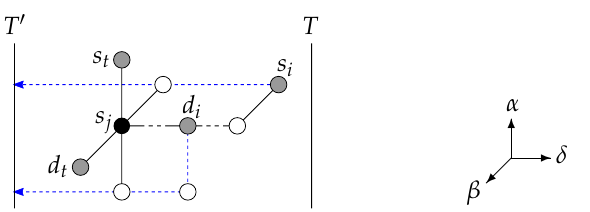
Figure 5. Illustration of the case n = c = 3 with the pair ( s i , d i ) blocking 3 paths for the pair ( s j , d j ) when routed to the subtorus T (cid:48) . Vertex s j is not routable to subtorus T without going through T (cid:48) . (Dimension names are given on the right for reference.)